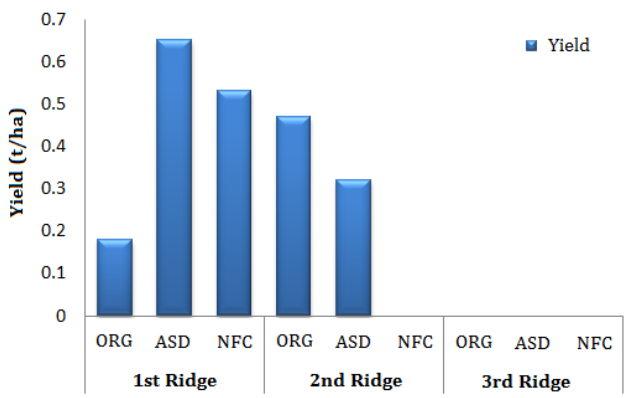
Figure 11. Mean values of marketable yield (t ha − 1 ) for each treatment with three different fertilizations (ORG = organic fertilizer, NFC = unfertilized control, ASD = anaerobic digestate fertilizer).